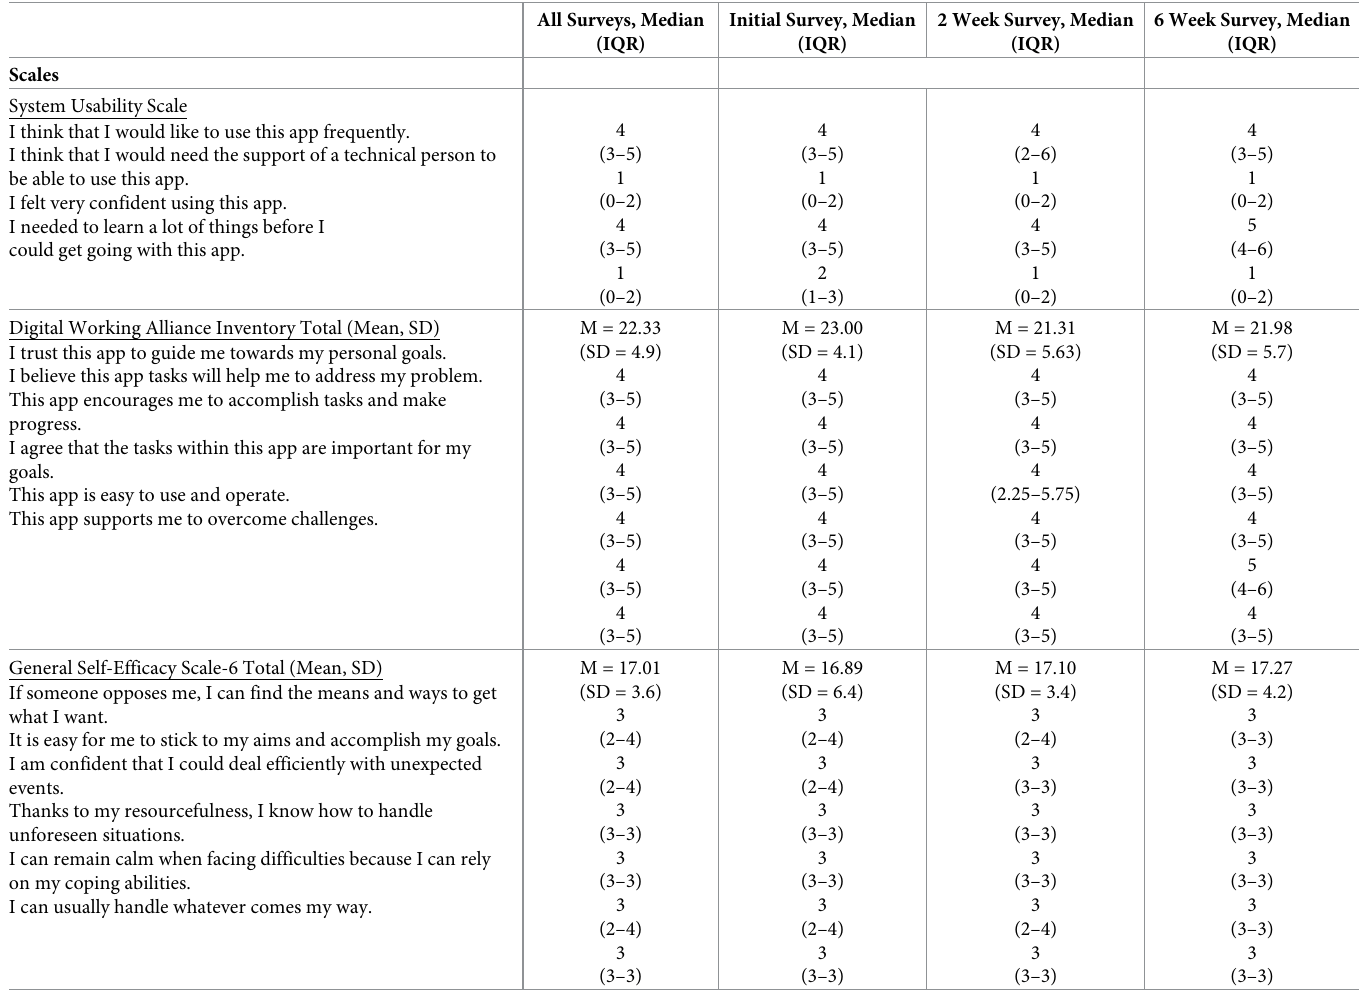
Table 2. SUS, D-WAI, and GSE survey averages throughout study duration.